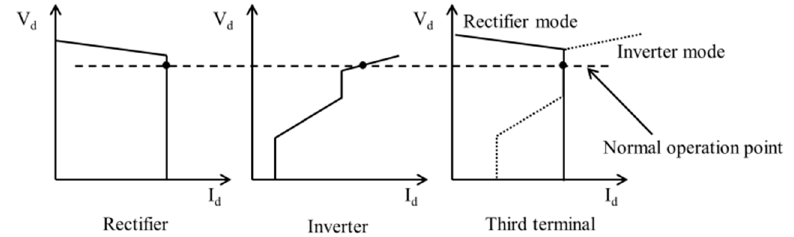
Figure 10. Line Commutate Converter (LCC) MTDC operation characteristics.